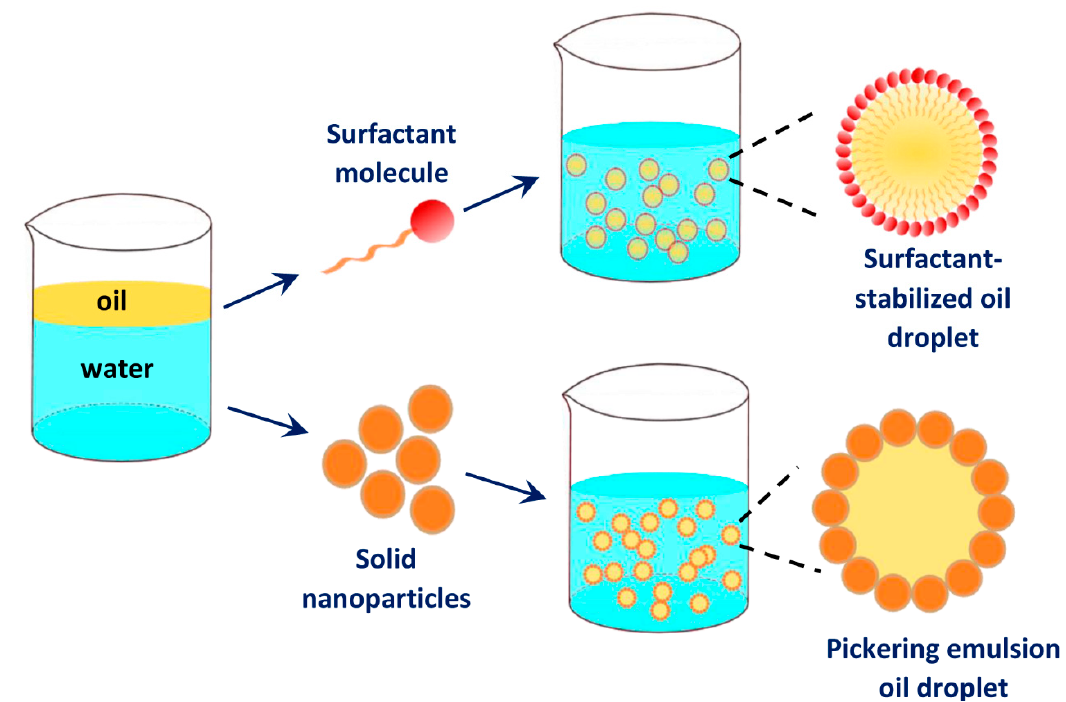
Figure 1. A schematic diagram of surfactant-stabilized and nanoparticle-stabilized oil droplets in an oil-in-water (O/W) emulsion (adapted from [16]).